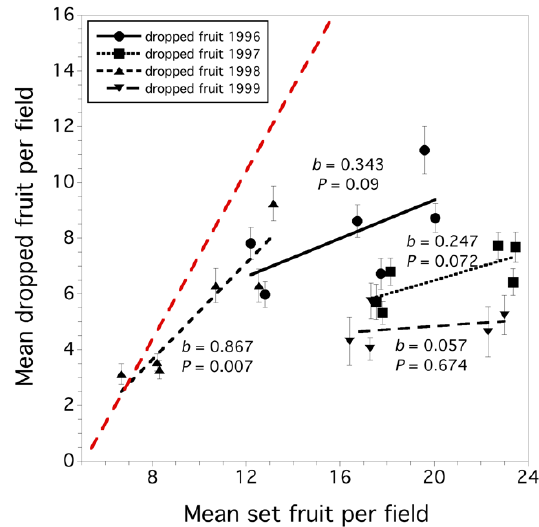
Figure 9. The average wild blueberry fruit drop determined by the average set fruit for each field (a single data point) within each year in eastern Maine, USA. Slope values are represented by “b” and the significance of the slopes (whether greater than 0) are given by the P values. The error bars are standard errors per field and the red dashed line is the 1:1 relationship between the set fruit and dropped fruit where set fruit are dropped and thus rendering no harvestable yield; so, the closer the regression lines are to the dashed red line, the greater the fruit drop.